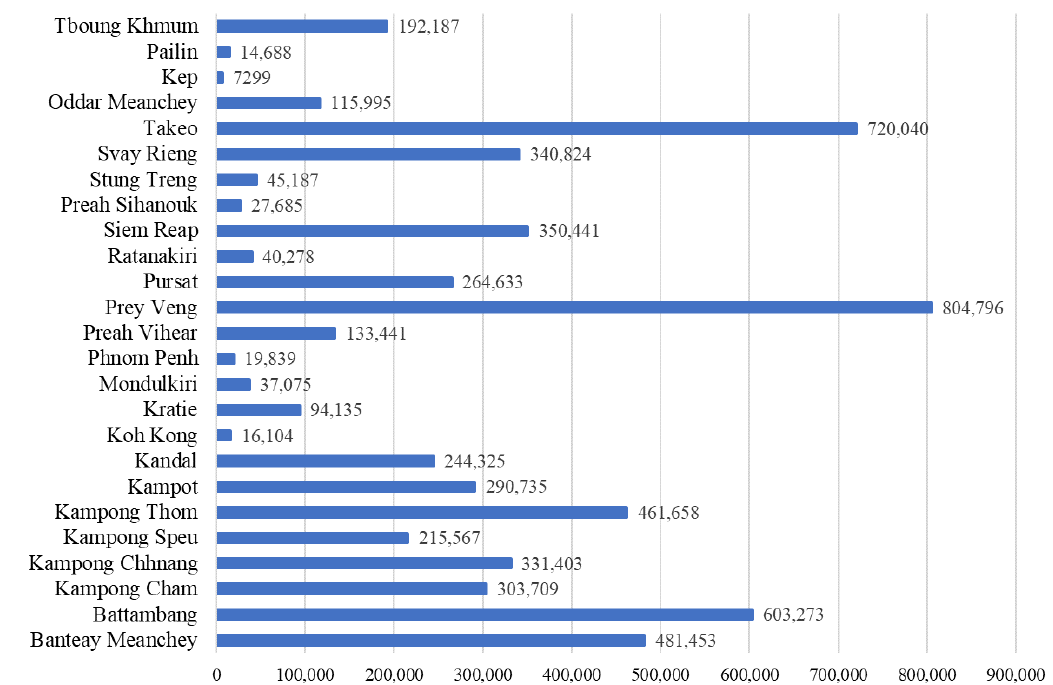
Figure 4. Annual rice straw estimation in 25 provinces of Cambodia.